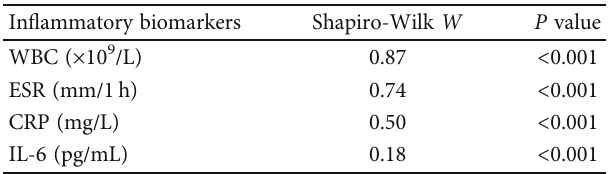
Table 3: Distribution tests regarding serological levels of the in fl ammatory